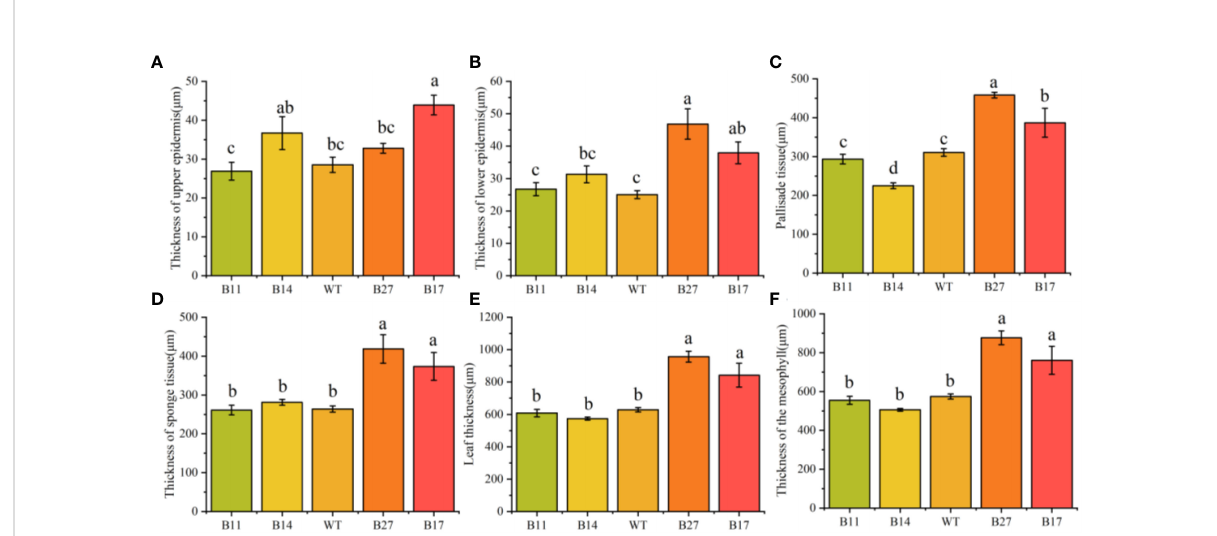
FIGURE 3 Statistical analysis of thickness (n=30) of upper epidermis, lower epidermis, palisade tissue, sponge tissue, leaf and mesophyll cell of asexually propagated second generation transgenic plants. Data are means ± SE of 30 biological replicates. Different letters indicate statistically signi fi cant differences between genotypes as determined by ANOVA using Tukey-Kramer posthoc test (P < 0.05). (A) Thickness of upper leaf epidermis of transgenic and wild type. (B) Thickness of lower leaf epidermis of transgenic and wild type. (C) Thickness of palisade tissue of transgenic and wild type. (D) Thickness of sponge tissue of transgenic and wild type. (E) Thickness of leaf of transgenic and wild type. (F) Thickness of mesophyll of transgenic and wild